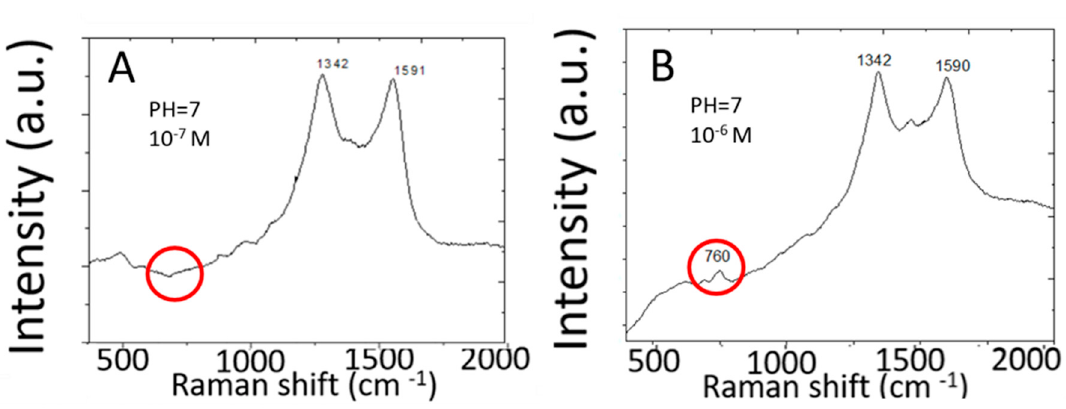
Figure 3. SERS spectra of adenine in water measured by two-dimensional array of silver nanoparticles on a planar copper foil. ( A ) 10 − 7 M, ( B ) 10 − 6 M.